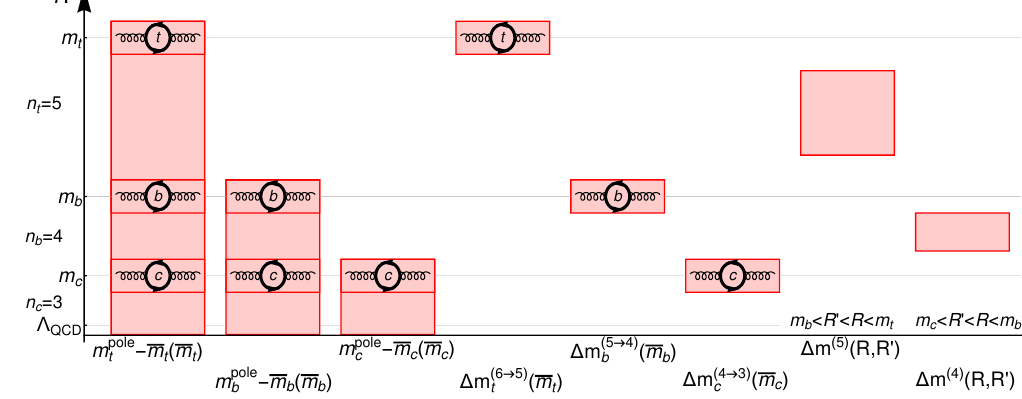
Figure 2 . Graphical illustration for pole-MS mass di(cid:11)erences, the MSR-MS mass matching cor- rections and MSR mass di(cid:11)erences for di(cid:11)erent R scales. They constitute the major contributions in the RG analysis of the heavy quark pole